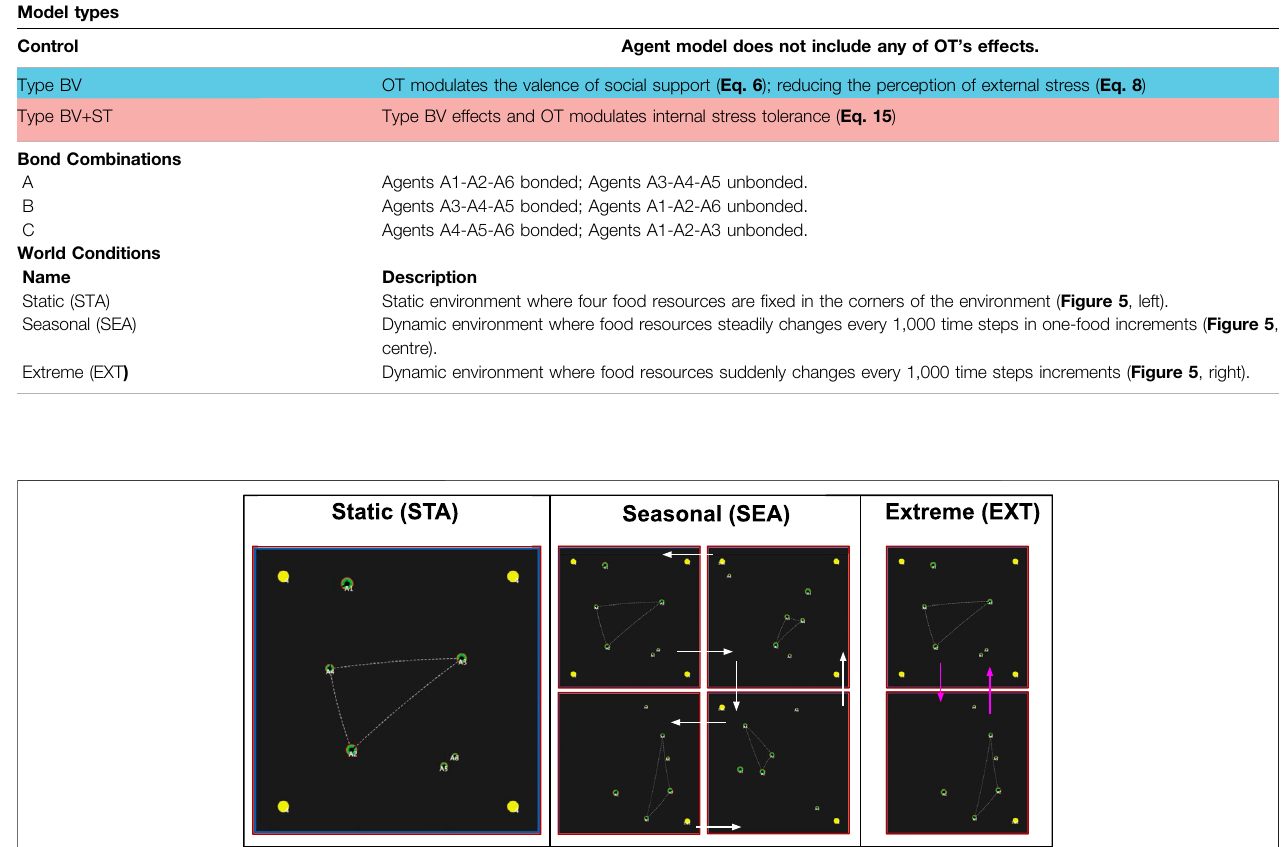
TABLE 3 | Table summarising the three experimental parameters and a brief description of each experimental condition. Coloured cells correspond to the illustration of the modeltypesin Figure6 .BV=BondValence;BV+ST=BondValence+StressTolerance.Worldconditionsareillustratedin Figure5 .Equationsrefertoourmodellingof each respective effect. Agent number refers to her hierarchical rank (1 = highest, 6 = lowest).